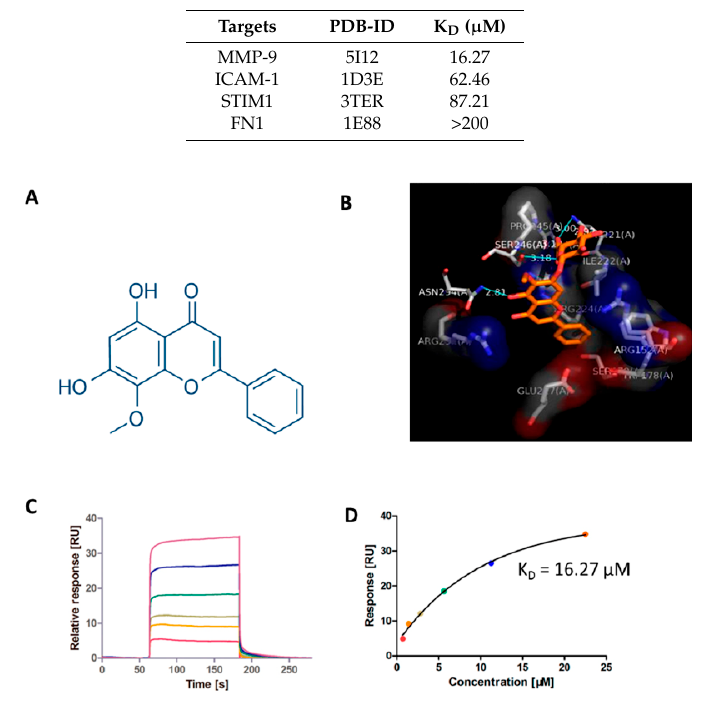
Table 2. The binding parameters of the interaction between immobilized targets and wogonin.